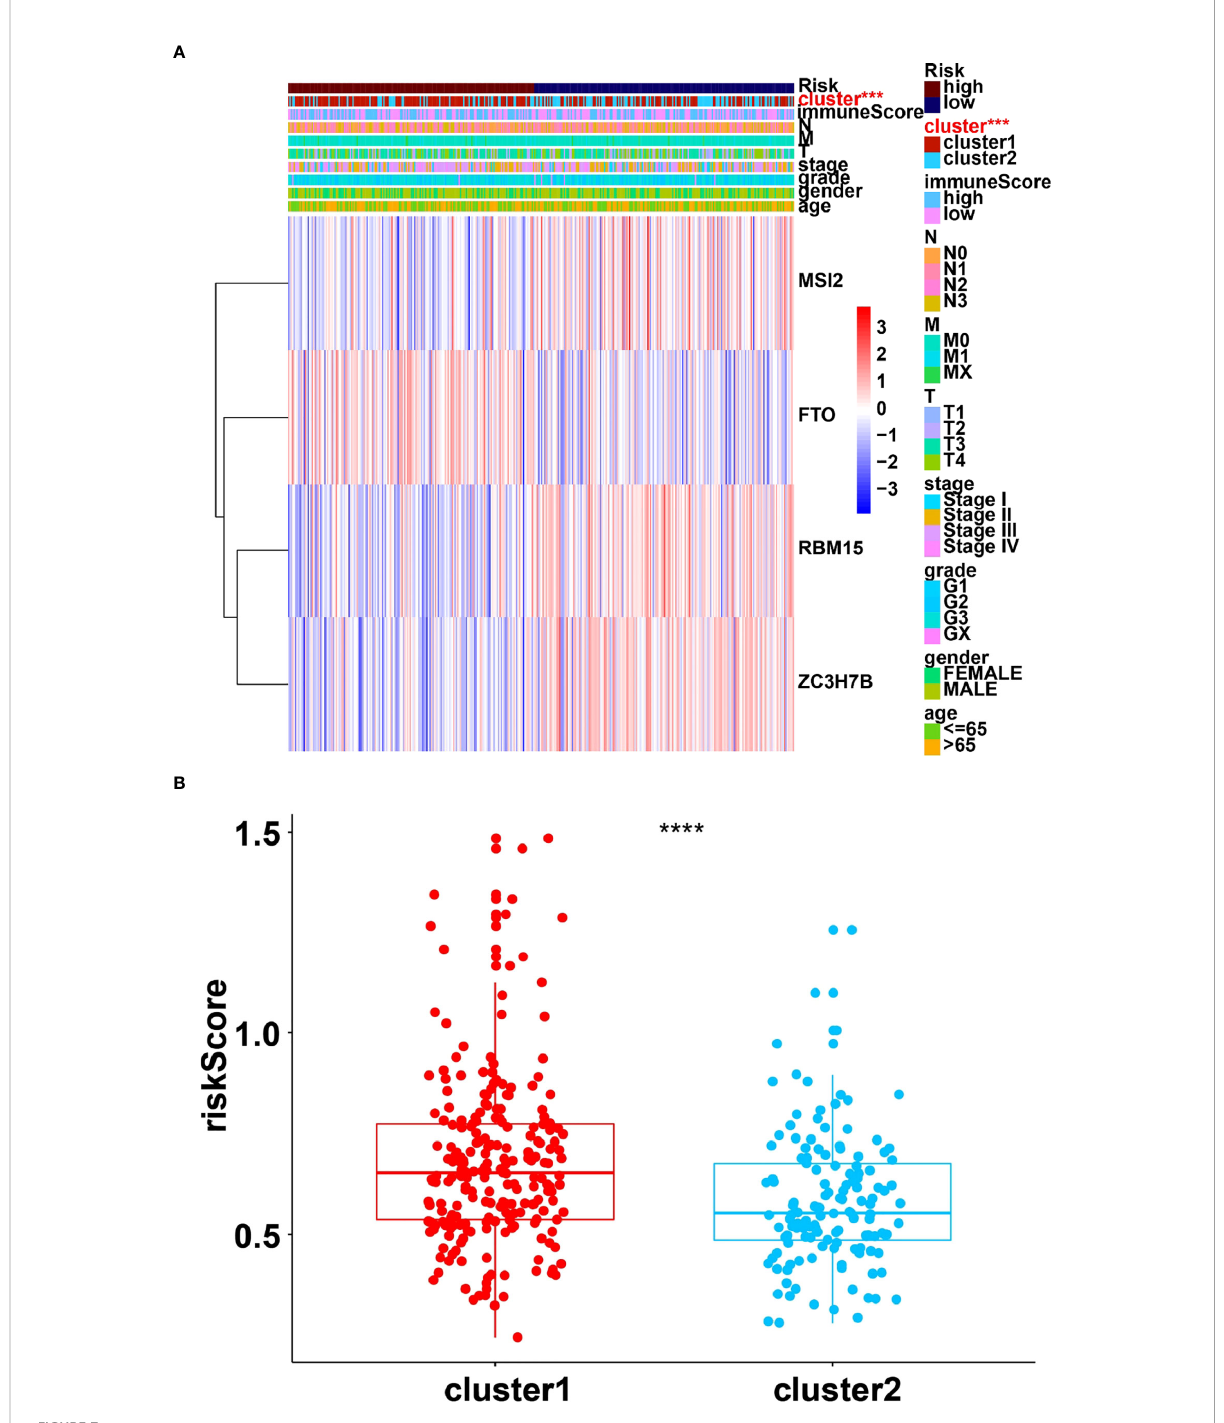
FIGURE 7 (A) , Heatmap of clinicopathologic features of STAD cohort. (B) , Distribution of RiskScores strati fi ed by cluster1/2. ***p<0.001;